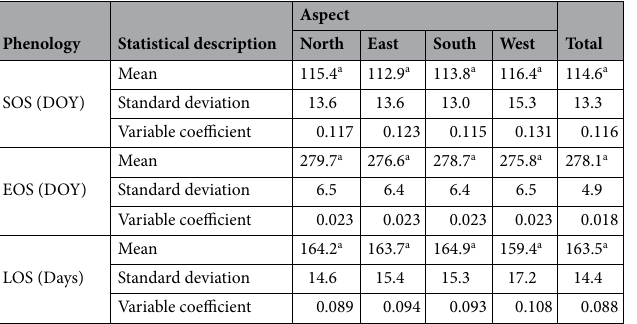
Table 3. Statistical characteristics of phenological indicators on different aspects. The same letters indicate that there is no significant difference between the different